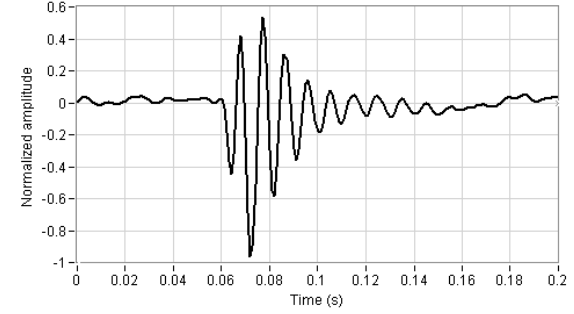
Fig. 7. An example of Korotkoff